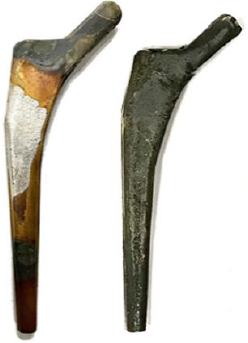
Figure 4. Photograph presenting the simple canister removal. The cut-out sample ( left ) and the canister shell ( right ).